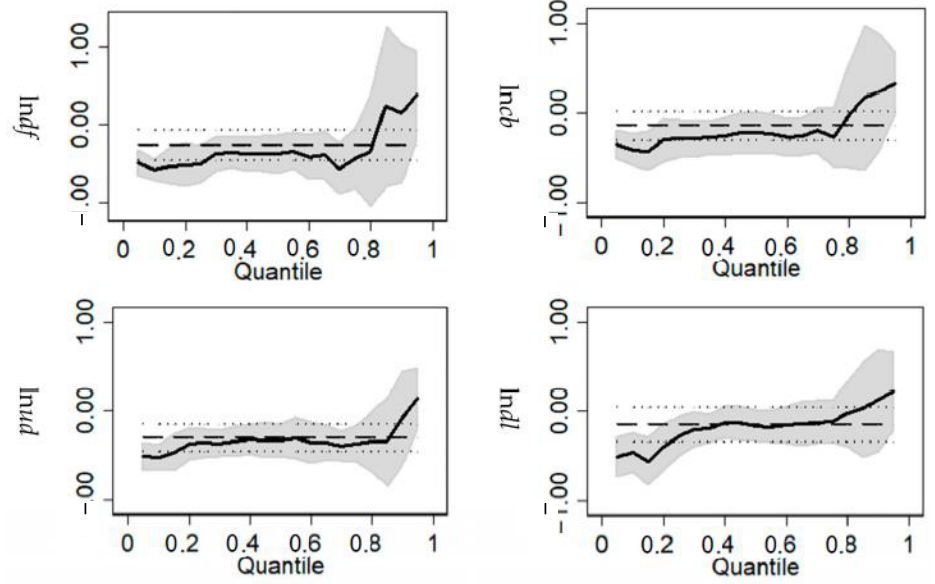
Figure 4. Quantile regression results of the impact of digital finance on green development.